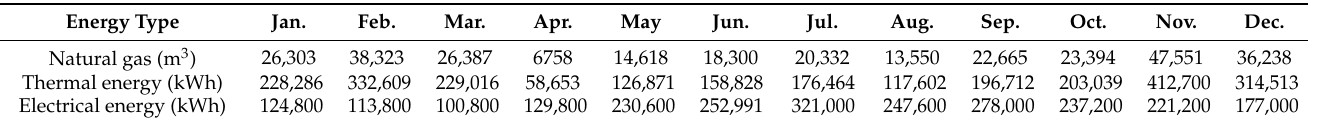
Table 3. Monthly consumption of natural gas, thermal energy, and electrical energy in the previous year of operation.